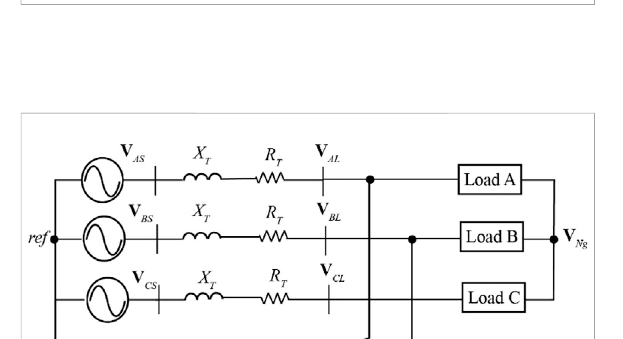
FIGURE 4 Single-phase circuit topology TCR.